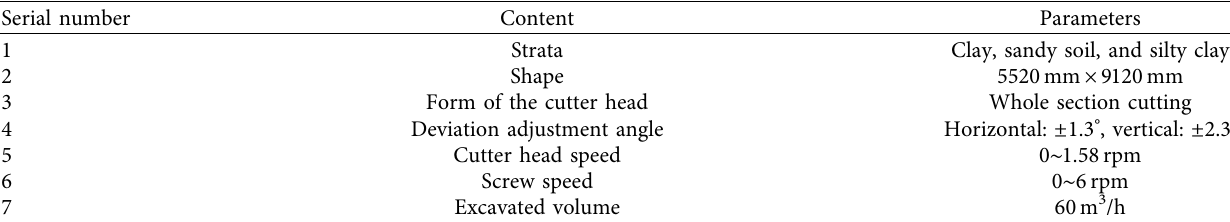
Table 1: Technical parameters of the rectangular pipe jacking